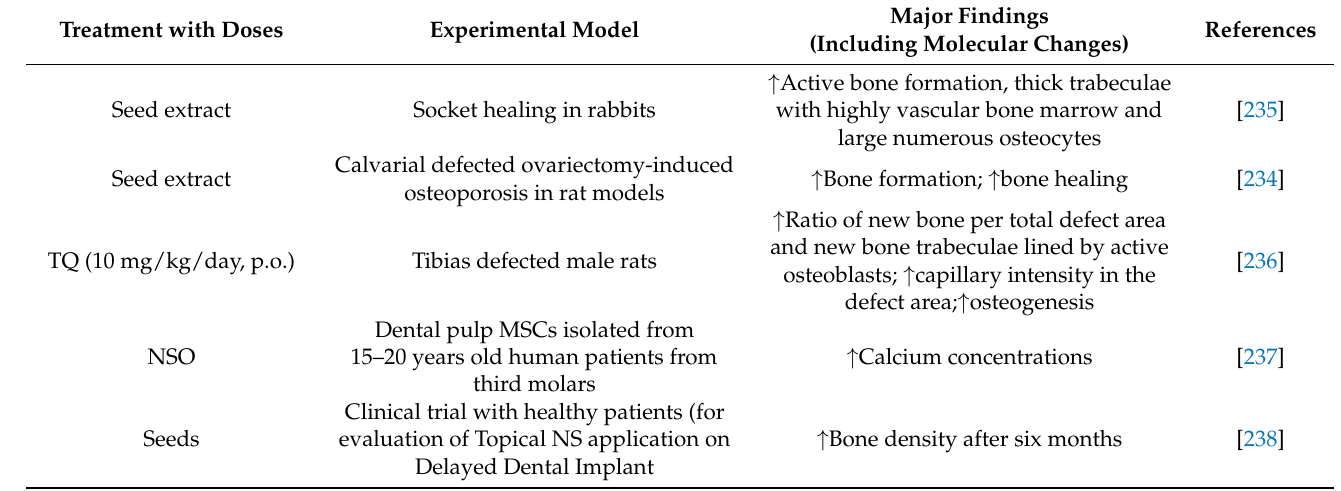
Table 10. Comprehensive summary on the bone regenerative effects of black cumin. Treatment with Doses Experimental